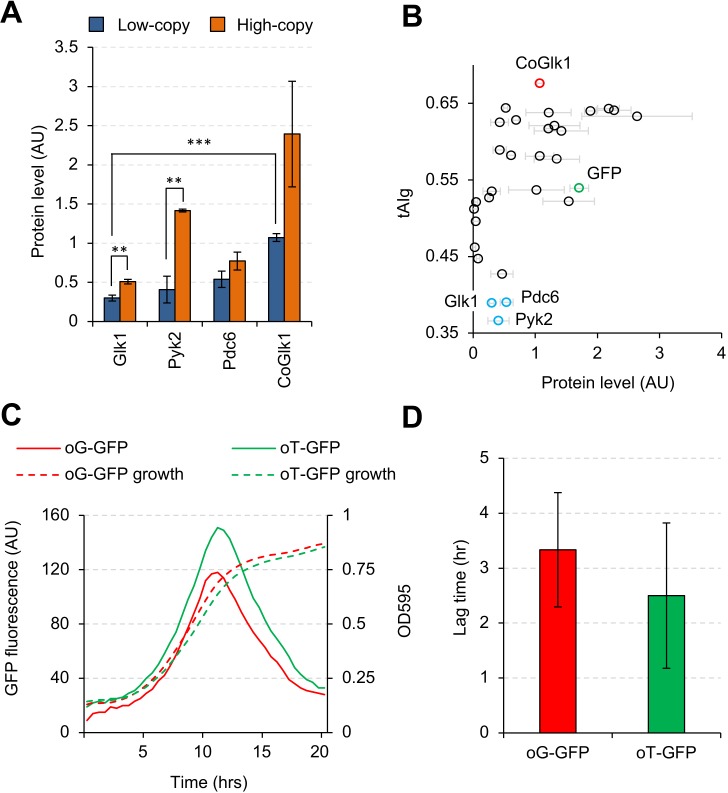
Codon usage affects the expression level, but not the synthesis timing, of Glk1.(A) Expression levels of Glk1, Pyk2, Pdc6, and codon-optimized GLK1 (CoGlk1) in the indicated conditions. (B) Relationship between the tAIg and the expression level of each glycolytic protein in low-copy conditions. Protein level data are the same as those shown in Figure 2B. (C) Growth curves and GFP fluorescence of cells expressing codon-optimized GFPs. oG-GFP (tAIg = 0.40): a GFP gene whose codons were optimized for the GLK1 codon usage. oT-GFP (tAIg = 0.64): a GFP gene whose codons were optimized for the TDH3 codon usage. (D) Lag time between the timings with the maximum GFP fluorescence and the maximum growth rate. Timings of the maximum GFP fluorescence and the maximum growth rate are the time points with maximum second derivatives of GFP fluorescence and growth curves. The error bars indicate the standard deviations of the means. **p<0.01; ***p<0.001 in Welch's t-test.10.7554/eLife.34595.021Figure 6—source data 1.This spreadsheet contains all data and statistical values associated with the figure.